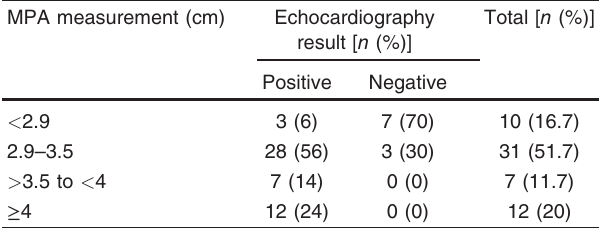
Table 6 Relation between echocardiography results and main pulmonary artery measurement MPA measurement